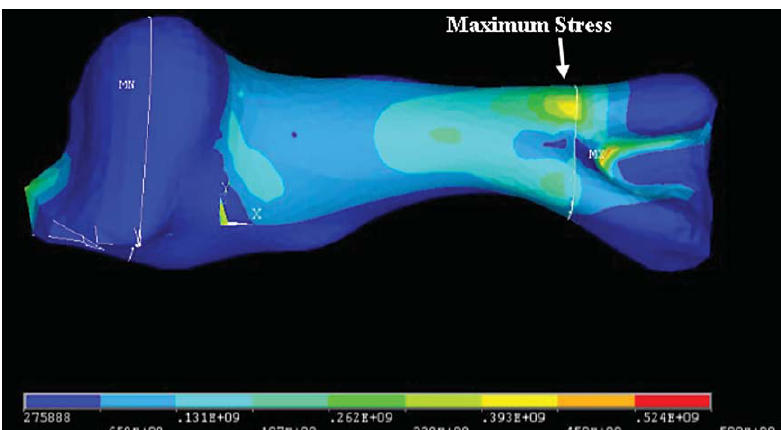
Fig. 6. Stress distribution in basic compression test.